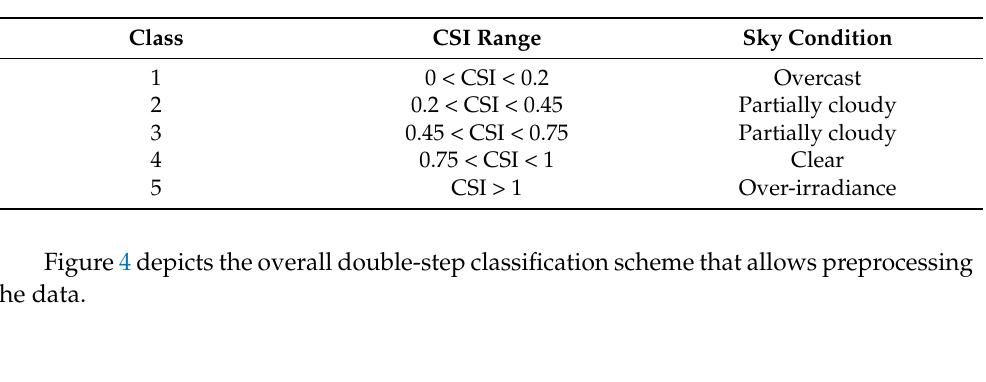
Table 1. Threshold values of CSI for classes